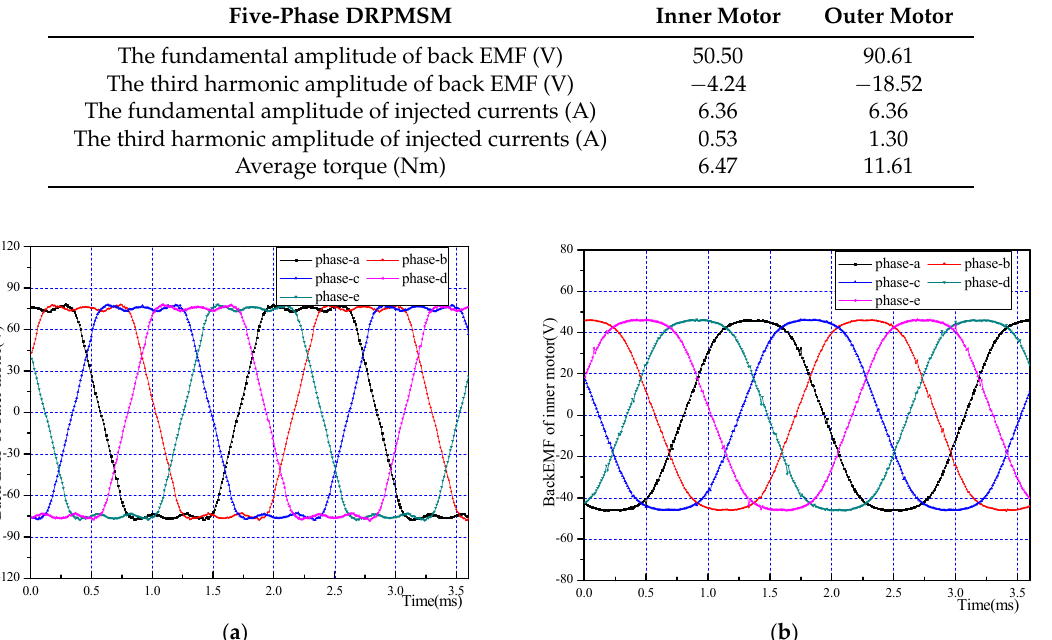
Figure 10. The back EMF waveform of ( a ) the outer motor and ( b ) the inner motor.